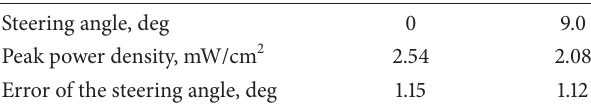
Table 3: Measured beam